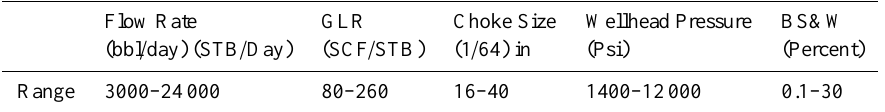
Table 2. Range of data used for the